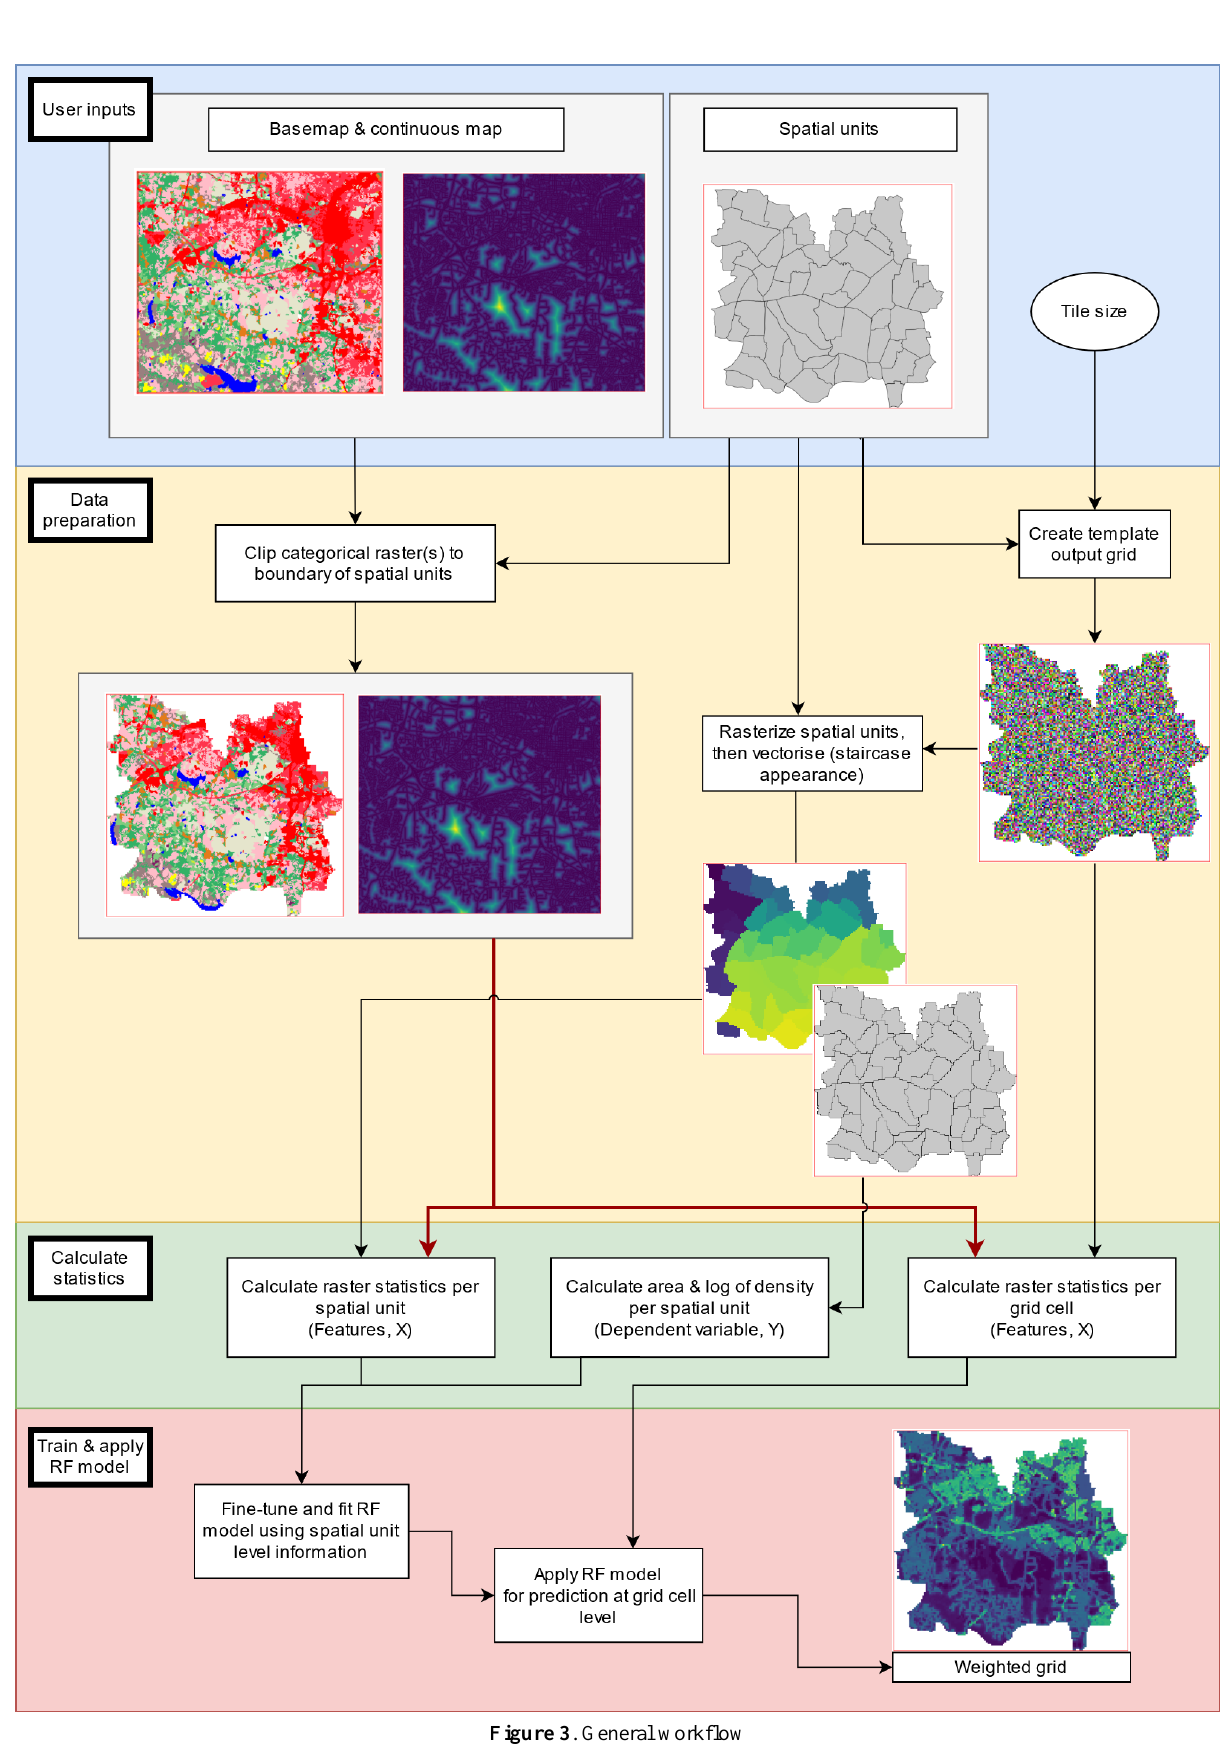
Figure 3 . General